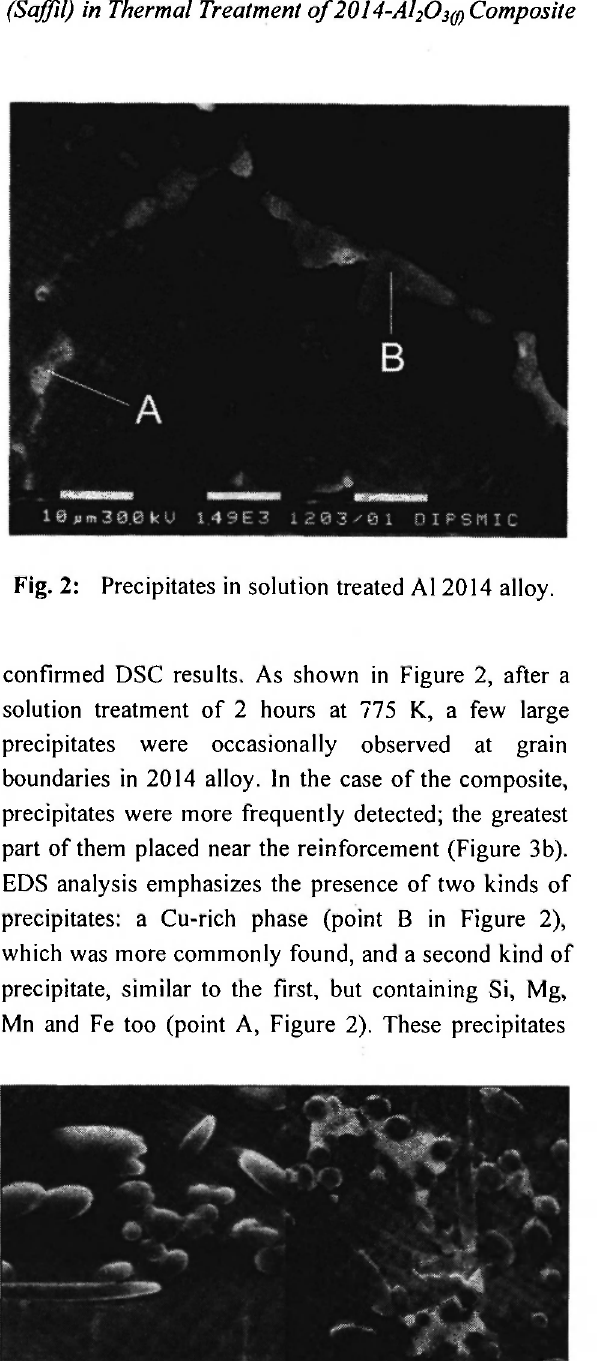
Fig. 3: Microstructure of solution treated Al 2014/ Saffil composite: (a) zone free from precipi- tates, (b) unsolutionized precipitates at matrix/fiber